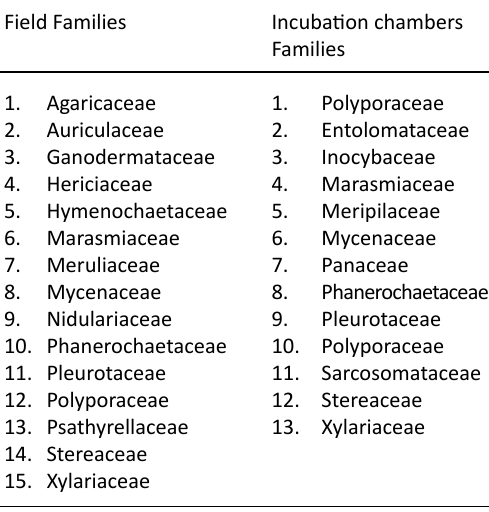
Table 3. Common families of wood-decay fungi collected in the present study from both the field and incubation